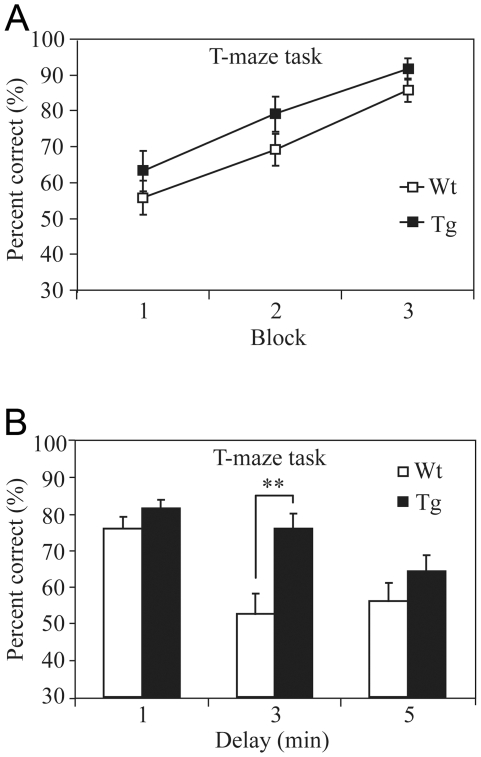
Enhancement of Spatial Working Memory in Transgenic Rats.A: NR2B transgenic rats exhibited the similar learning curve in comparison to that of controls during the T-maze spatial working memory test. The delay interval between the sample-run and trial-run is 15 seconds. B: Spatial working memories were tested using various intervals. Better performance in the transgenic rats was noted in the 3-min delay non-matching to place test. Data are expressed as mean±SEM. Asterisk, p<0.05; double asterisk, p<0.01; post hoc analysis.